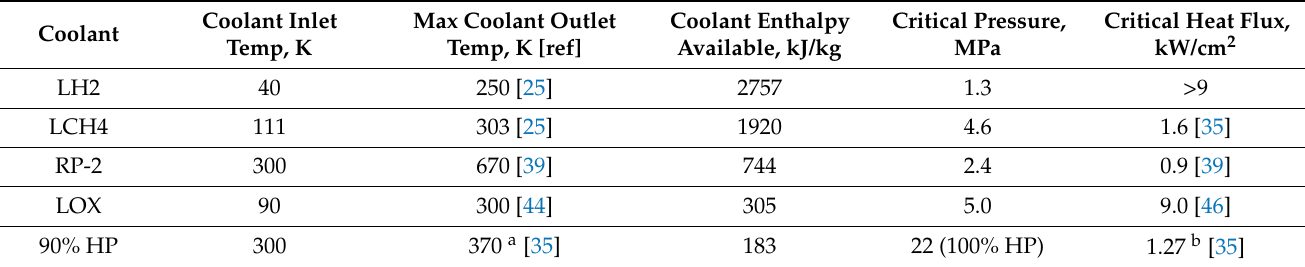
Table 4. Coolant characteristics from available literature and fluid